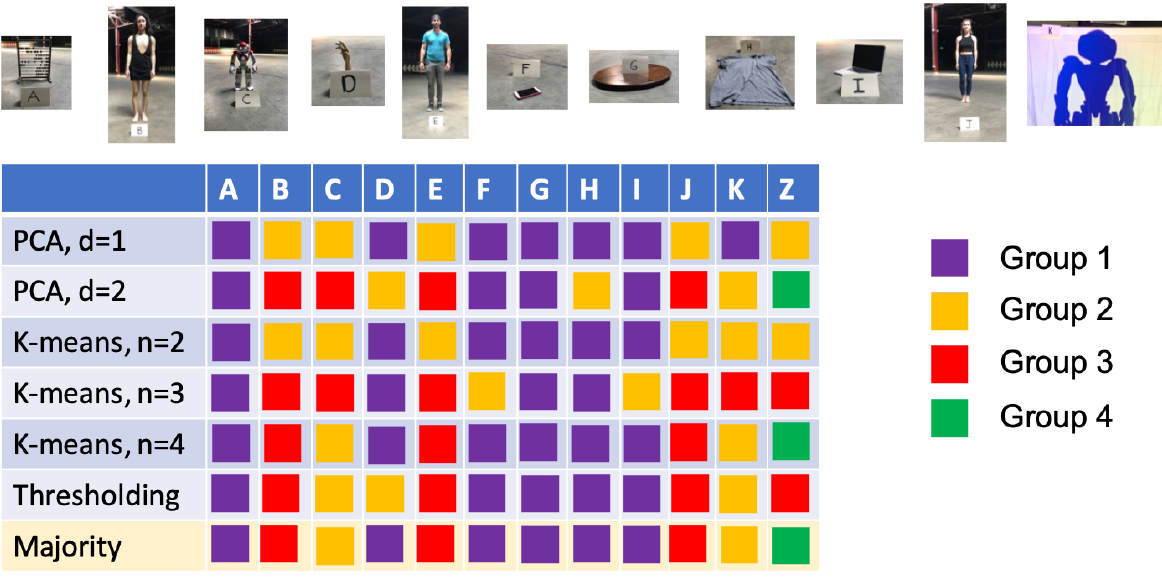
Figure 7: The line up of objects and the structure of ratings of each is presented in this figure. Top: Systems A-Z shown in the order they were presented onstage. Bottom: co-variance, clustering, and threshold analysis of the system ratings to determine groupings of objects that were similarly rated. We used three grouping techniques: principle component analysis, k-means clustering with random cluster ini- tialization, and thresholding of averaged ratings (across Pre-Survey, Mid-Survey, and Post-Survey). For principle component analysis, the first dimension contained 41% of the variance and the second brought that to 61% with each component thereafter contributing less than 10% each; thus, organization according to these two components is presented here. An additional clustering method, k-means, was used for 2, 3, and 4 clusters with randomized initial seeding. Thresholds were determined that captured a similar structure. The results of all three methods show similar, but not definitive, structure in the data that is consistent with qualitative observations of system type accord- ing to the idea of “expressivity”. A majority grouping is suggested to capture the features of most of the prior clustering methods. While “Self” or “System Z” is the most inconclusive, having no majority grouping, it is always found in the highest order group, hence its assign- ment. This produces groups with the following consistent labels: objects, robots, humans, and